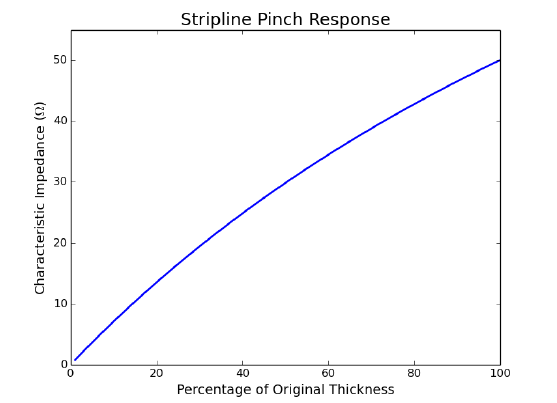
Figure 11. Effect of pinch on the characteristic impedance of a